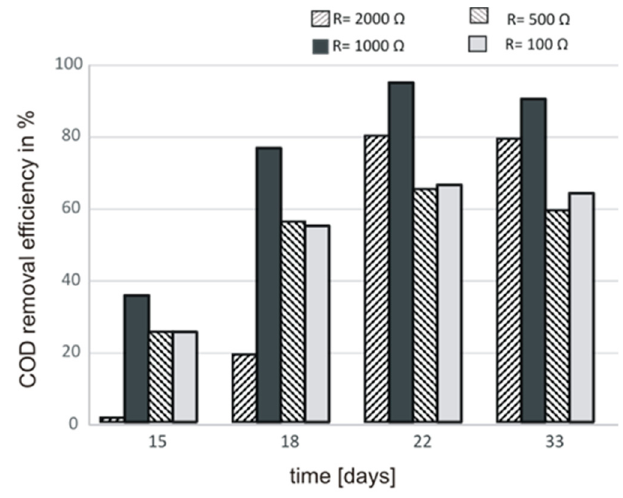
Figure 4. Influence of external resistance on COD removal efficiency of MFC fed mixed wastewaters. Analyses were made in duplicates, differences between measurements did not exceed 1%.